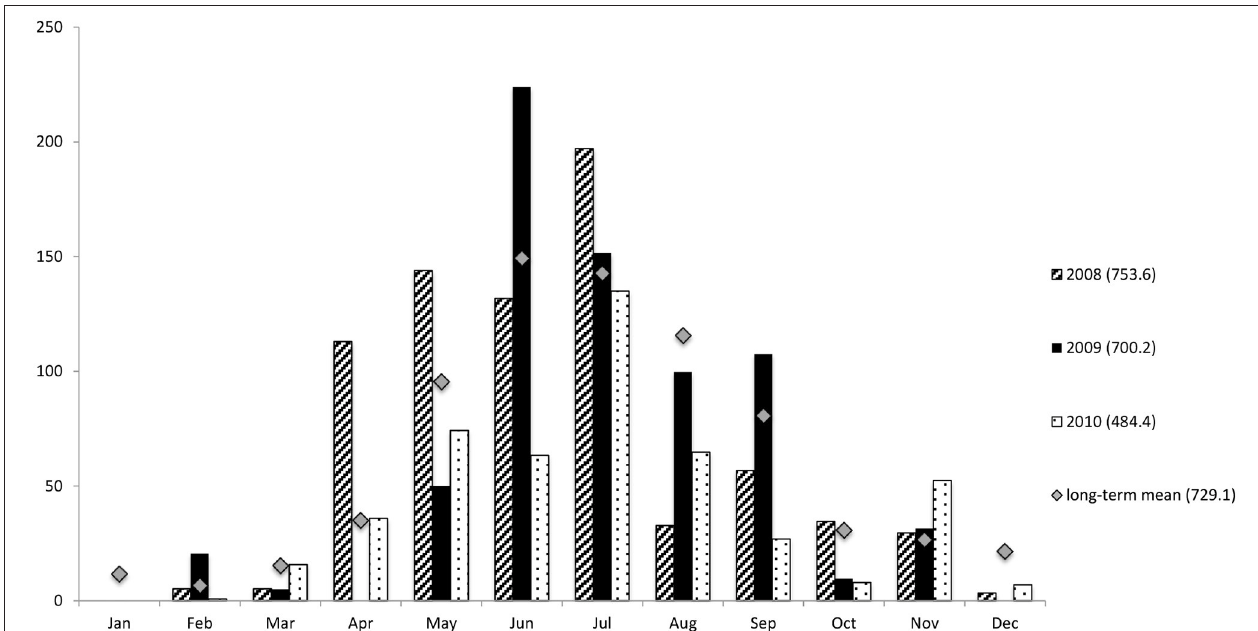
FIGURE 2 | Total rainfall (mm) in Bunbury from 2008–2010. For this study summer constitutes the months of January-March. Winter constitutes the months of June-September to coincide with sampling seasons. Mean monthly data 1995–2012. Numbers in brackets represent the total rainfall of the associated year, or annual mean rainfall 1995–2012. Data courtesy of the Australian Bureau of Meteorology.